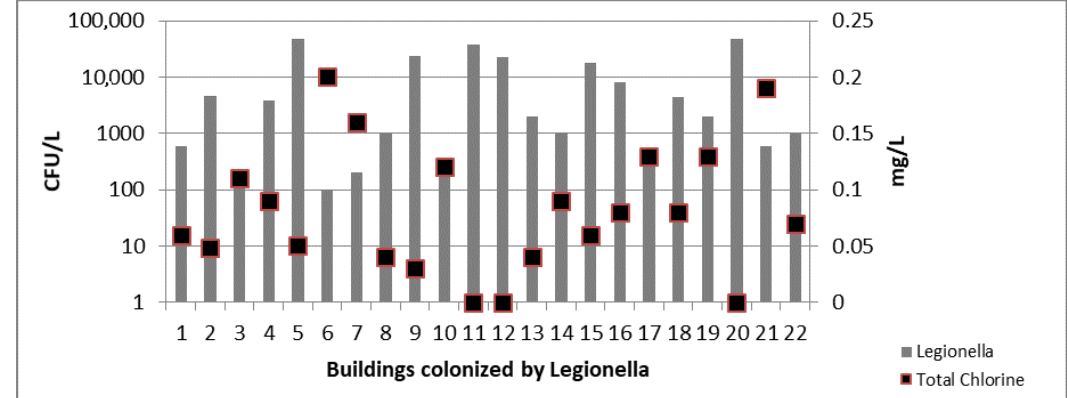
Figure 1. Legionella counts and total chlorine concentration detected in 22 colonized IB.